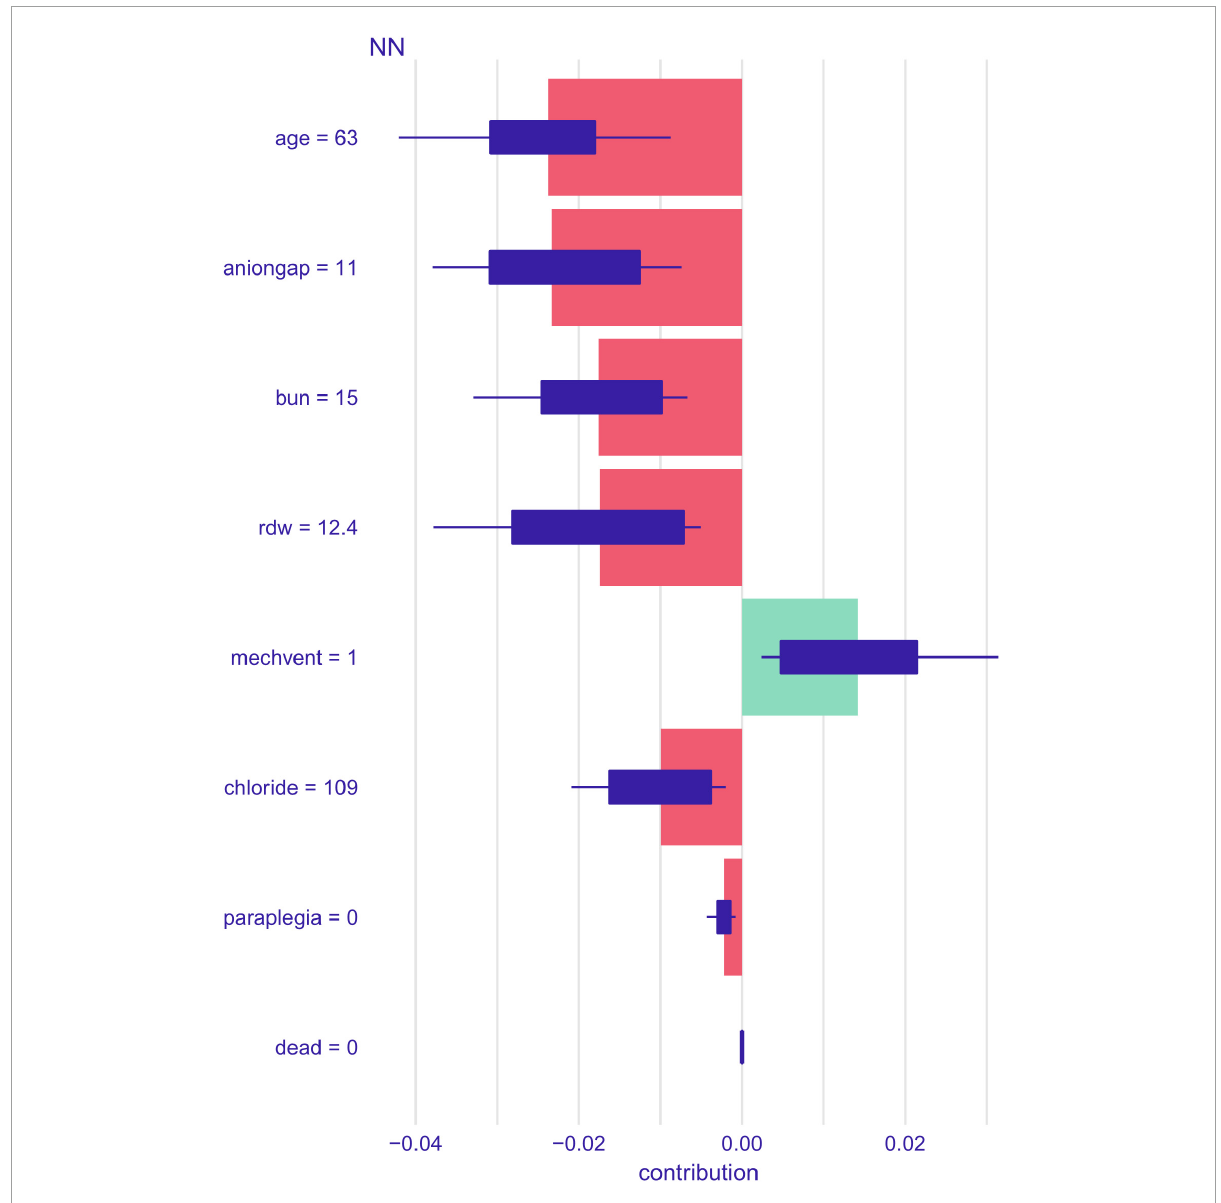
FIGURE5 SHAP contribution values of different variables for a single sample of the NN